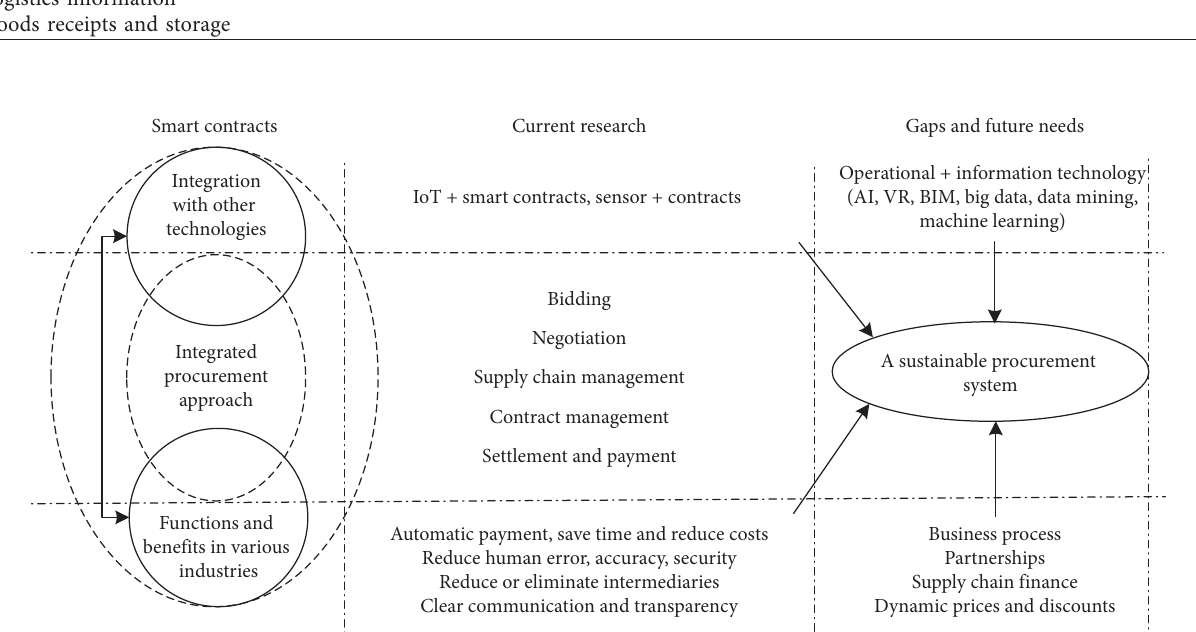
Figure 10: A research framework for smart contracts in future